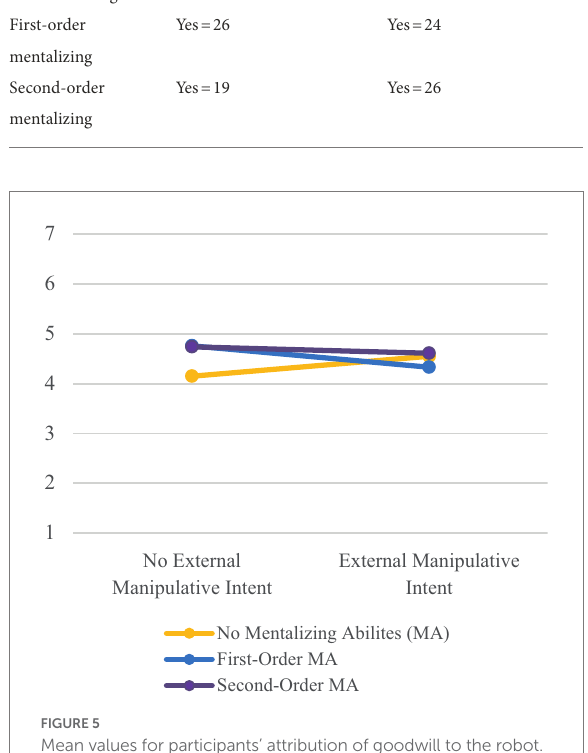
FIGURE 5 Mean values for participants’ attribution of goodwill to the